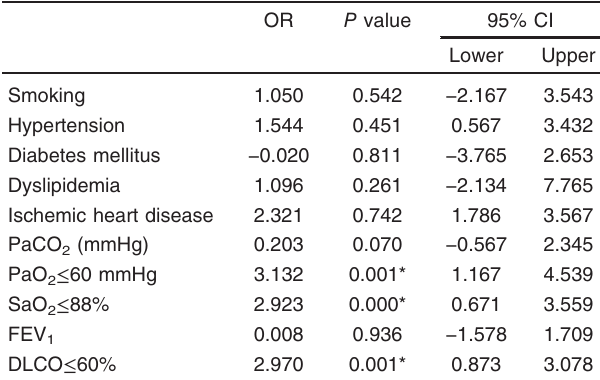
Table 5 Logistic regression analysis showing the predictors of erectile dysfunction among male patients with idiopathic